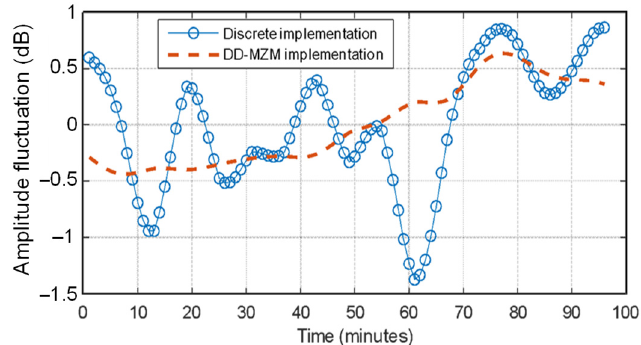
Figure 11. Amplitude stability of the proposed system with the EOM-AOM DOFC architecture and the DD-MZM in-chip DOFC architecture.